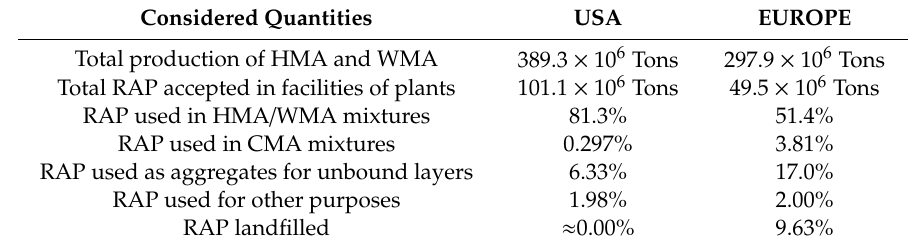
Table 1. Comparison of Reclaimed Asphalt Pavement (RAP) uses in the USA and Europe: data from